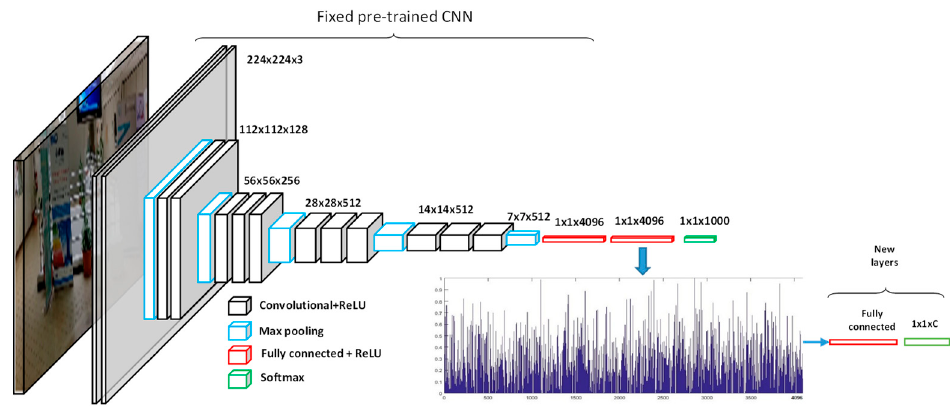
Figure 2. Feature extraction using a pre-trained Convolutional Neural Network (CNN) model, where a new fully connected layer followed by a softmax layer with C neurons (equal to number of classes) are added for learning.